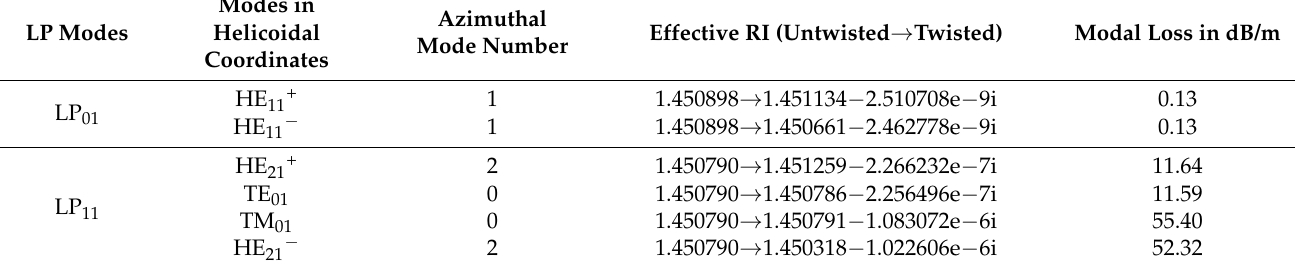
Table 2. Degeneracy breaking of a linearly polarized LP mn mode group, increment of the effective RI from untwisted (n eff ) to twisted (n (cid:48) ) fiber, and modal losses of a twisted heptagon-shaped eff